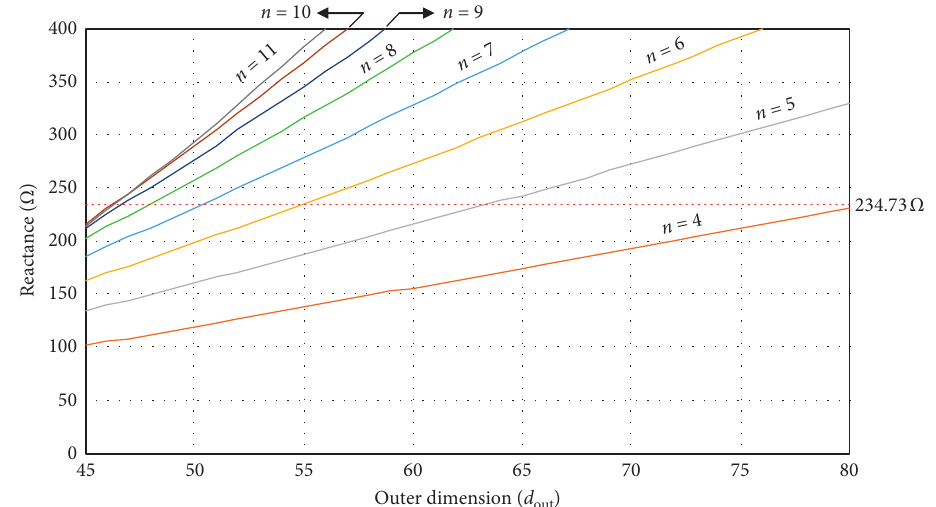
Figure 2: The inductive reactance of square spiral structure under variable numbers of turns ( n ) and outer dimension ( d